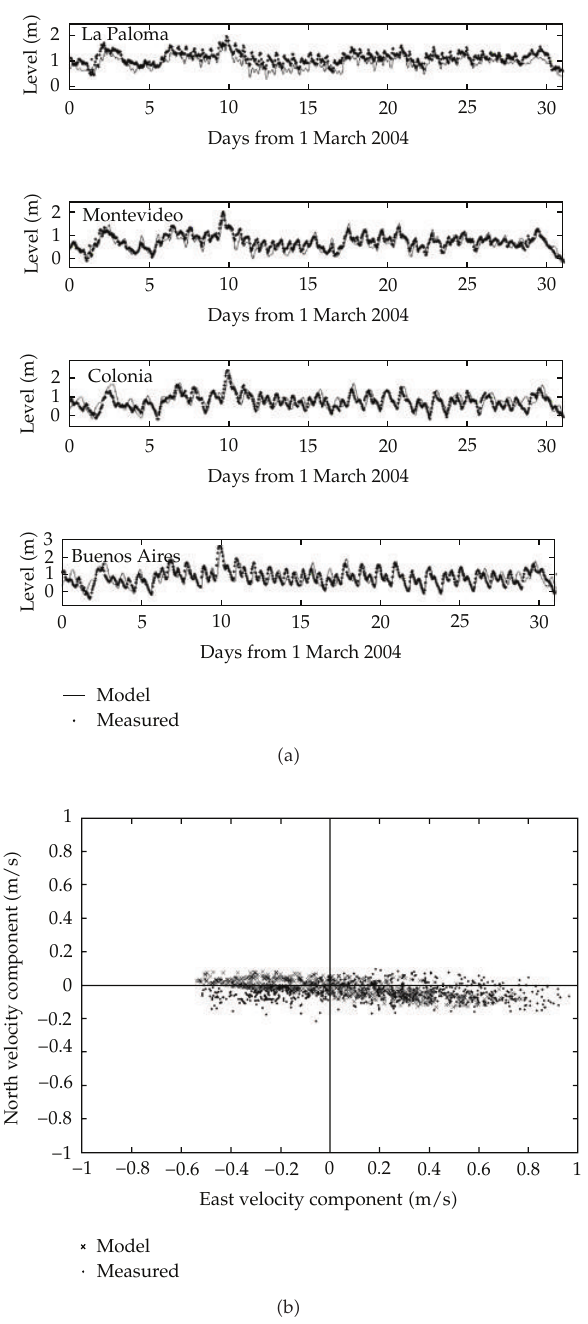
Figure 5: Temporal water level variation obtained with the model and measured in La Paloma, Mon- tevideo, Colonia, and Buenos Aires during the calibration period March 2004 (cid:3) a (cid:4) . Comparison of the spatial variation of the modeled and measured currents in Punta Brava during the days between 17 and 29 February 2004 (cid:3) b (cid:4)